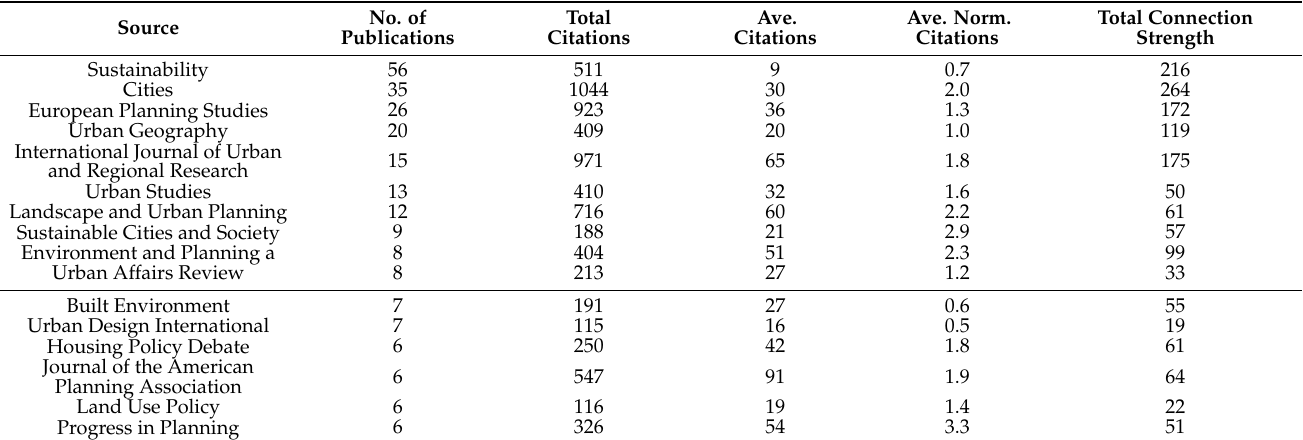
Table 1. List of journal source in SCT-related